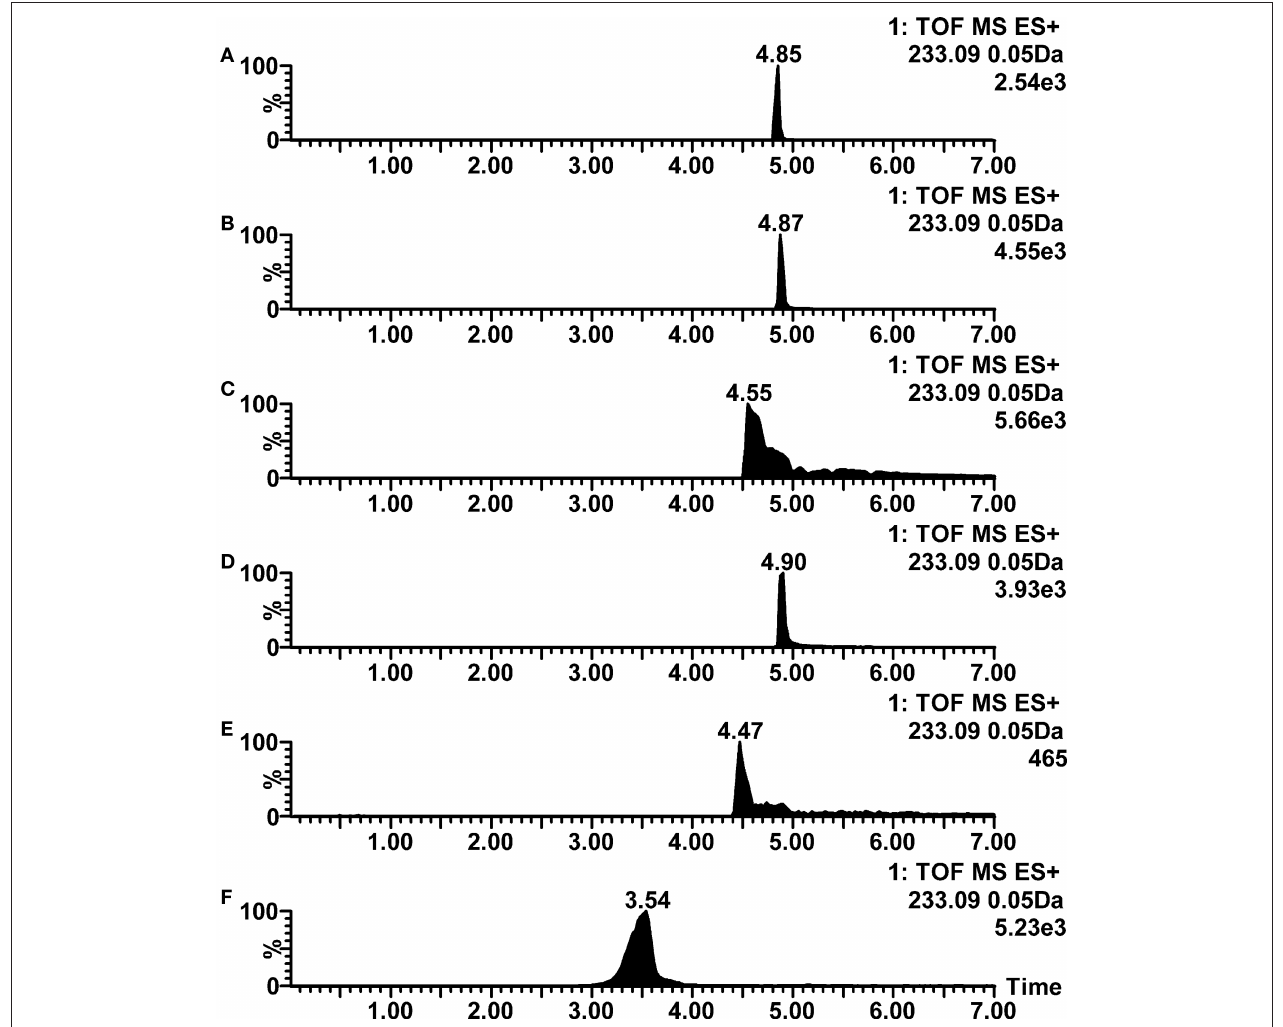
FIgurE 4 | Positive ion mode LC–ESI–TOF–MS ion chromatograms for nalidixic acid at various mobile phase pH conditions. (A) 0.1% formic acid (pH 2.8); (B) 0.1% acetic acid (pH 3.2); (C) 2 mM ammonium formate (pH 6.0); (D) 0.05% acetic acid with 5 mM ammonium acetate (pH 4.4); (E) 2 mM ammonium acetate (pH 6.7); (F) 10 mM ammonia (pH